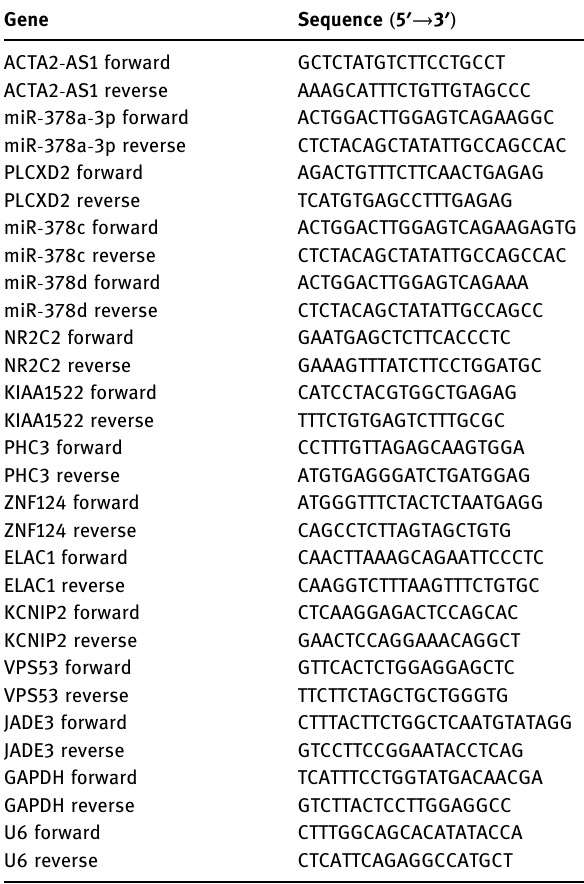
Table 1: Sequences of primers used for RT - qPCR Gene Sequence ( 5 ′ → 3 ′